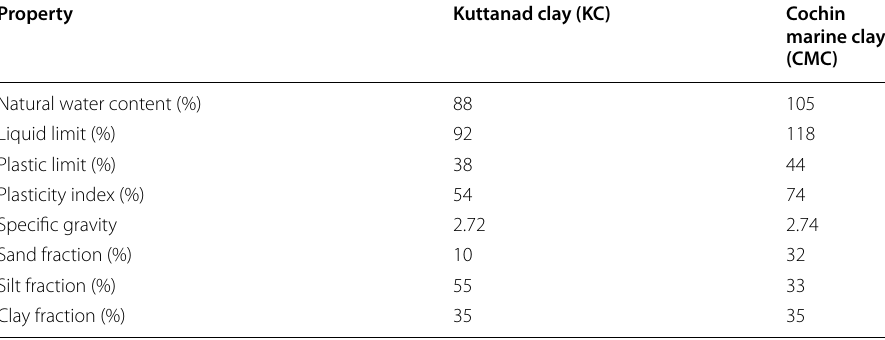
Table 1 Properties of the soil used in the study Property